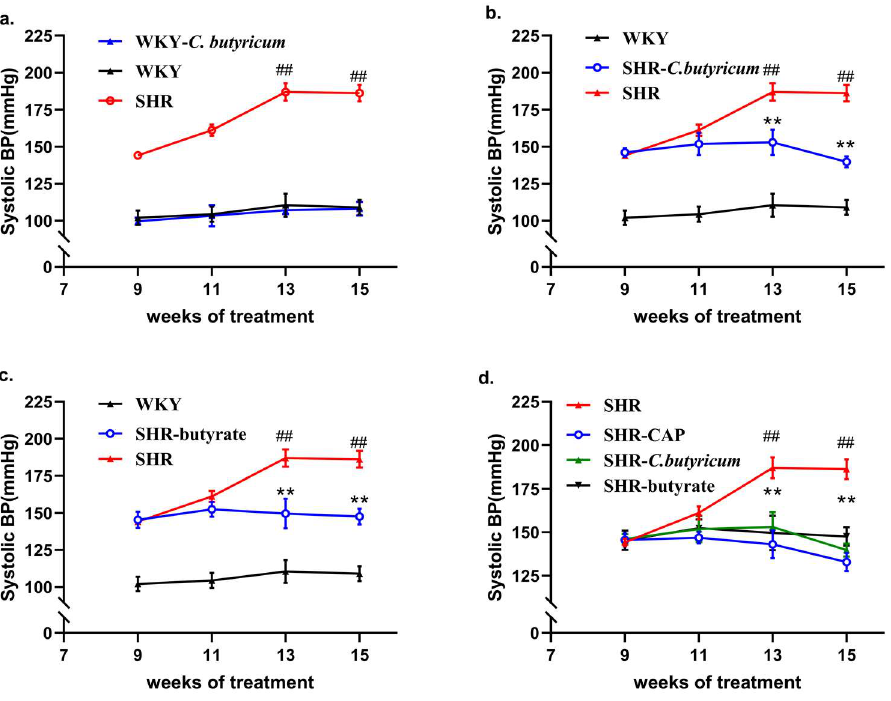
Figure 1. C. butyricum and butyrate prevented SHR-induced hypertension. ( a ) SHR rats exhibited significantly higher SBP compared to WKY, and C. butyricum had no significant effect on SBP of WKY (SHR, n = 8 per group, WKY, n = 6 per group, WKY- C. butyricum , n = 8 per group). ( b ) The SBP of SHR decreased significantly after 4 weeks of C. butyricum treatment (SHR- C. butyricum , n = 8 per group). ( c ) The SBP of SHR decreased significantly after 4 weeks of butyrate treatment (SHR-butyrate, n = 8 per group). ( d ) The SBP of SHR decreased significantly after 4 weeks of captopril treatment (SHR-CAP, n = 8 per group), C. butyricum and butyrate prevented elevated SBP in SHR at weeks 11–15, but their SBP was higher than that of rats in the captopril-treated group. Data are shown as the mean ± S.E.M., ** p < 0.01 for SHR vs. SHR- C. butyricum or SHR-butyrate. ## p < 0.01 for SHR vs. WKY.